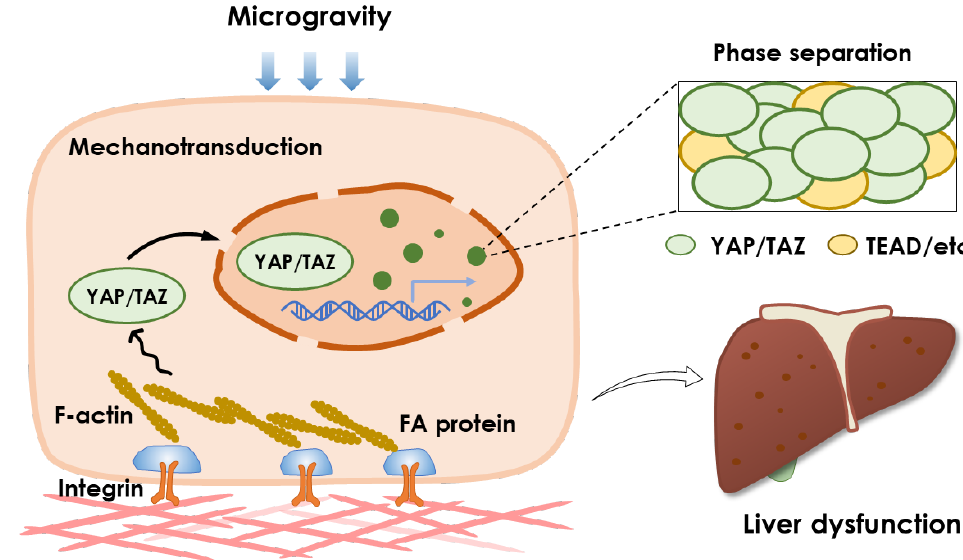
Figure 3. Mechanotransductive pathway and phase separation of YAP/TAZ may be responsible for liver dysfunctions induced by microgravity. Microgravity sensed by cells leads to cytoskeleton re- arrangement and nuclear deformation, affecting YAP/TAZ cytoplasmic-nuclear distribution. Fur- thermore, YAP/TAZ undergoes LLPS and forms super enhancers with TEAD, Med1, and other mol- ecules to promote transcription. This process is reasonably regulated by microgravity exposure since the weightless status delays phase separation of the modeled protein. Considering that YAP/TAZ is essential for liver metabolism, it is proposed that microgravity-dysregulated liver func- tions may result from YAP/TAZ inactivation through the disruption in mechanotransduction via cytoskeleton or nucleus, or disturbed phase separation via diffusion limitation.